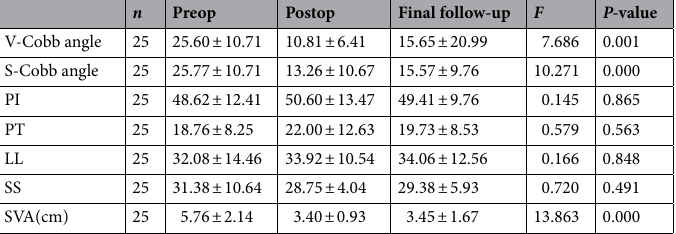
Table 3. Radiographic results. PI pelvic incidence, LL lumbar lordosis, PT pelvic tilt, SS sacral slope, Preop preoperative, postop postoperative, SVA sagittal vertical axis.